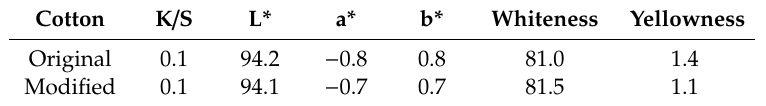
Table 1. Colorimetric properties, whiteness, and yellowness of the original and modified cotton